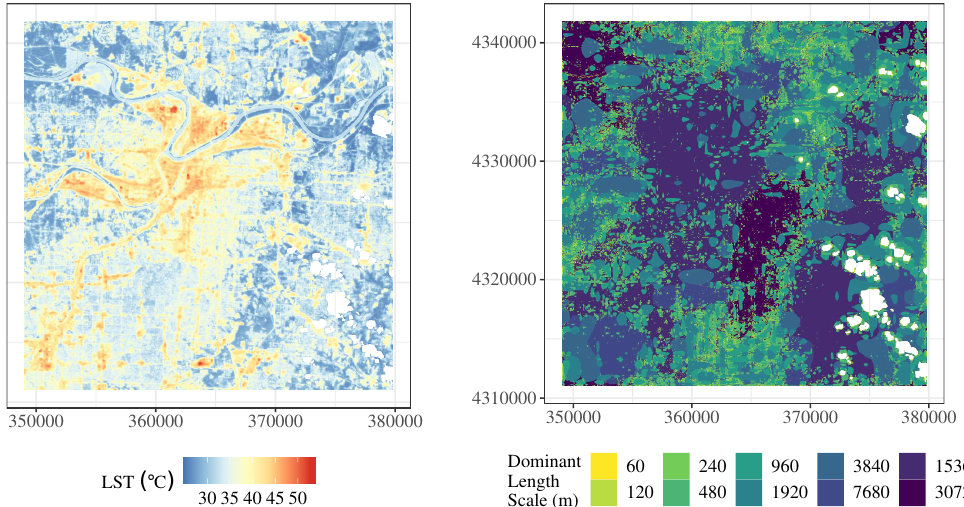
Figure 3. The dominant length scales ( right ) calculated from LST ( left ) for 25 July 2011. The dominant length scales represent the characteristic scales of the biophysical interactions that produce LST.